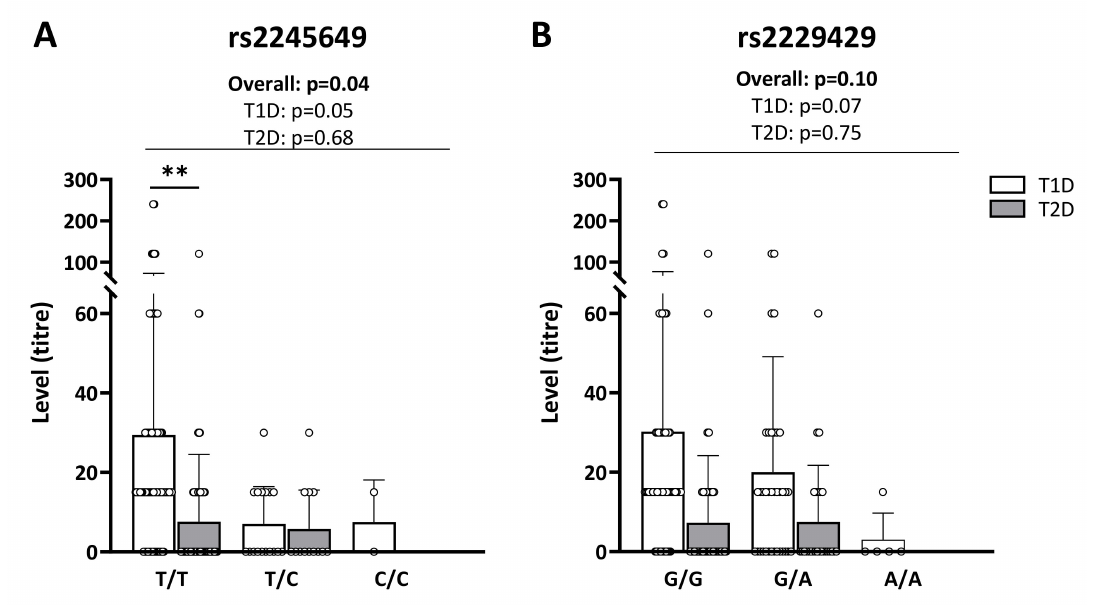
Figure 3. Anti-insulin antibody (IA) titres by INSR SNPs genotype. Shown are IA titres for patients with T1D ( n = 100, white bars) and patients with T2D ( n = 101, grey bars) in relation to the genotype distributions for ( A ) INSR rs2245649 and ( B ) rs2229429. Trend test performed by logistic regression with adjustment for age and sex. Trend tests and comparisons between T1D and T2D by genotype were performed with linear regression, adjusted for age and sex, ** p ≤